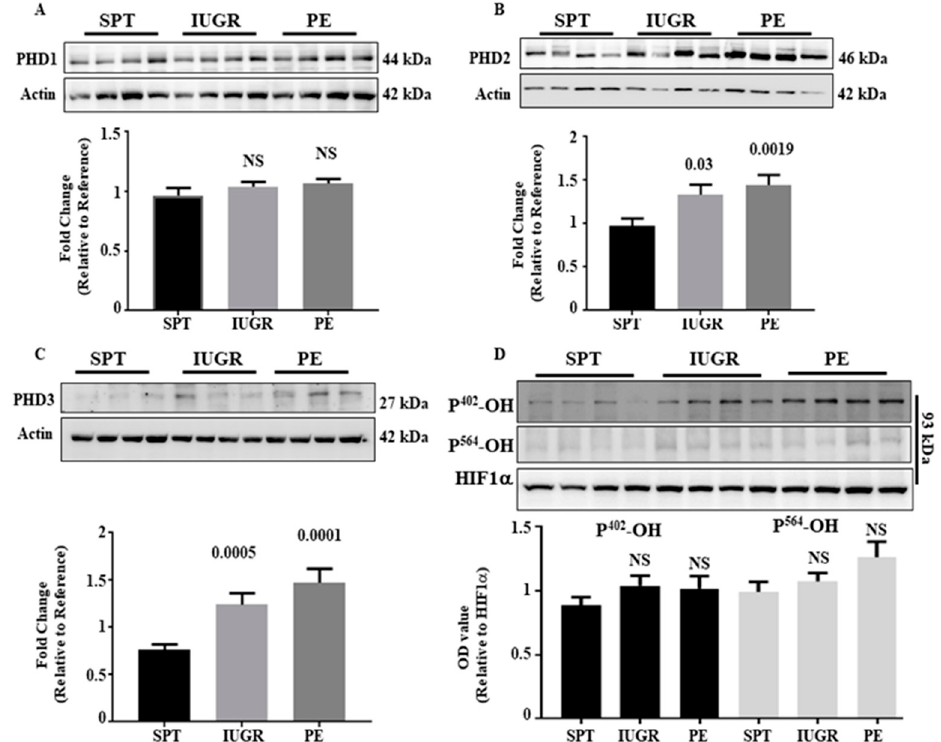
Figure 3. Expression of HIF-1/2 α regulatory proteins in the placentae of complicated pregnancies. Expression of the HIF- α regulatory proteins PHD1 ( A ), PHD2 ( B ), and PHD3 ( C ) was assessed by immunoblotting in placentae of normal ( n = 13), IUGR ( n = 16) and PE ( n = 19) pregnancies. Representative Western blot and densitometric analysis of expression are shown. β -actin is included as a loading control. ( D ) Function of PHD enzymes was assessed by immunoblotting for hydroxylated P 402 and P 564 in HIF-1 α . In this case immunoblotting for HIF-1 α was used as the loading control. The value of one normal pregnancy control was normalised to one and changes observed in the other samples shown as a fold change compared to this reference sample. Data represent mean ± SEM. p values as compared to normal pregnancy are indicated. NS = Not significant. Full gels for immunoblots can be found in SF3 and SF4.